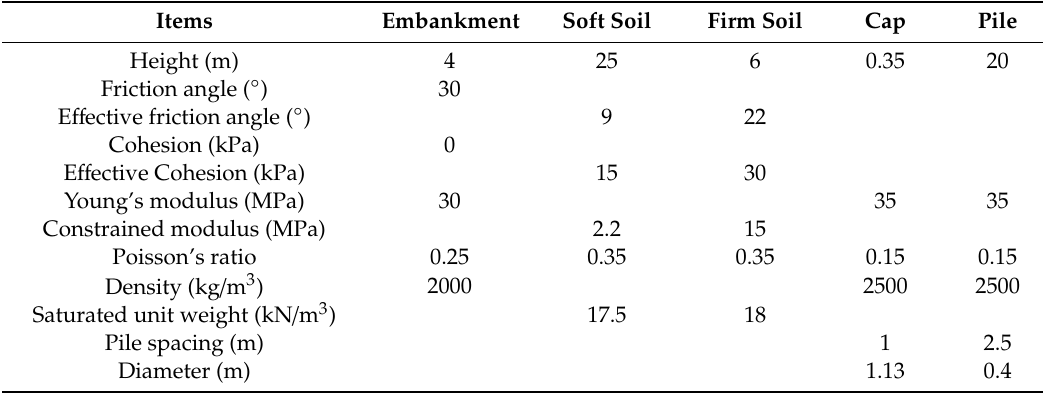
Table 2. Material properties and geometric parameters used in validation 2.